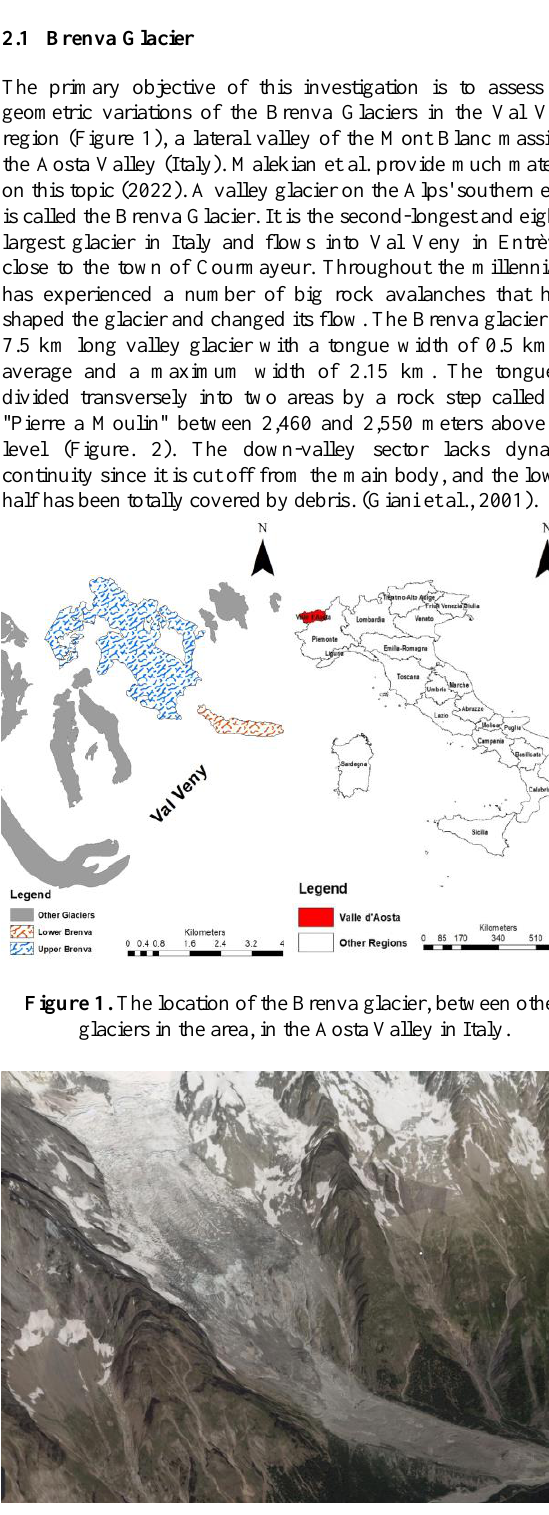
Figure 2. The separation of Brenva Glacier in the middle part by a rock step called ‘Pierre a